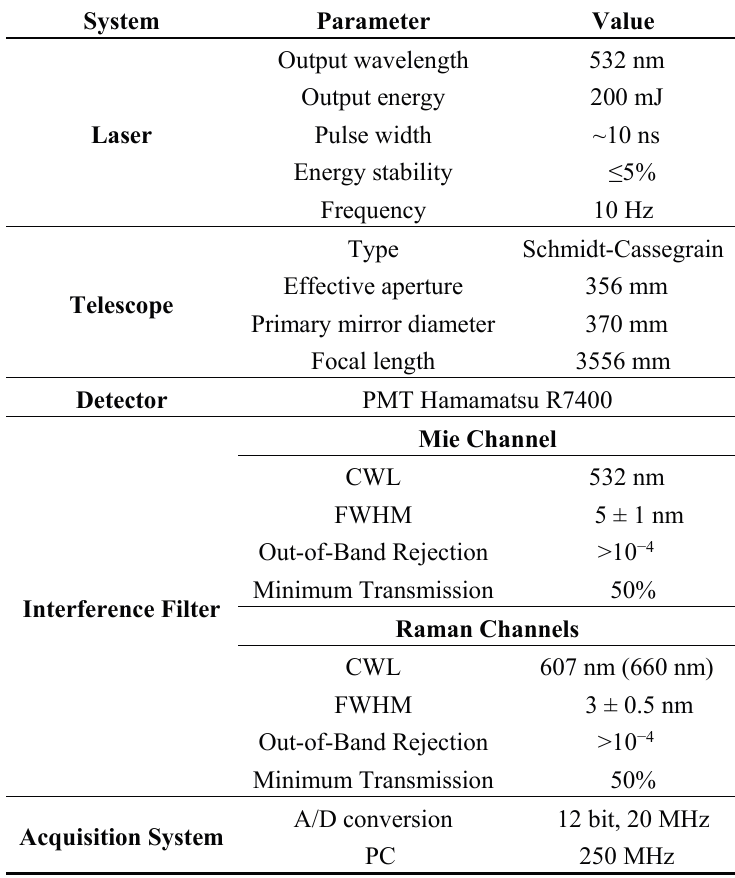
Table 1. Main technical parameters of the Raman Lidar